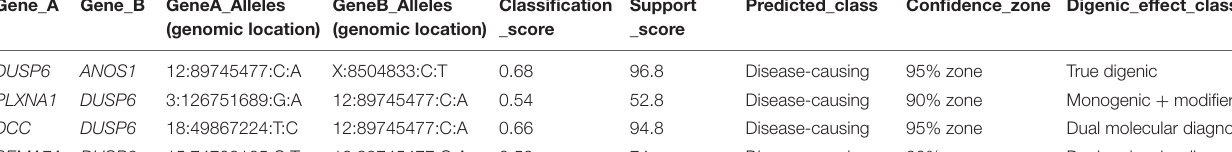
TABLE 3 | Disease-causing digenic combinations identified in HH12.